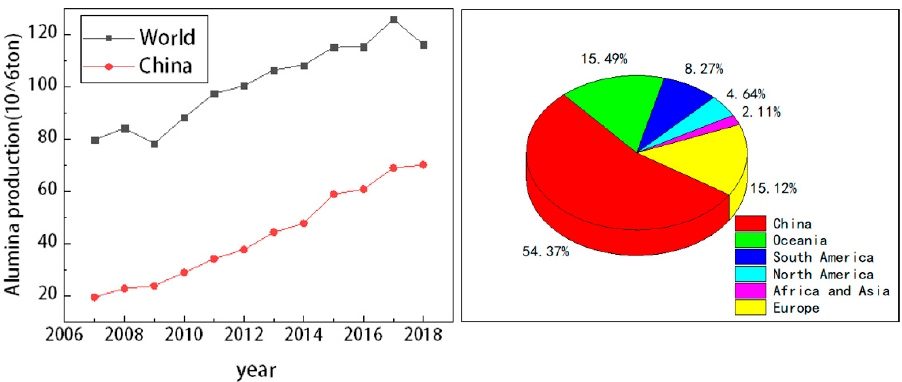
Figure 1. Global data from the International Aluminium Institute regarding annual alumina production worldwide and in China. Regional distribution of alumina production in 2017 [5–8]. Reproduced with permission from [5], published by Elsevier B.V., 2016.